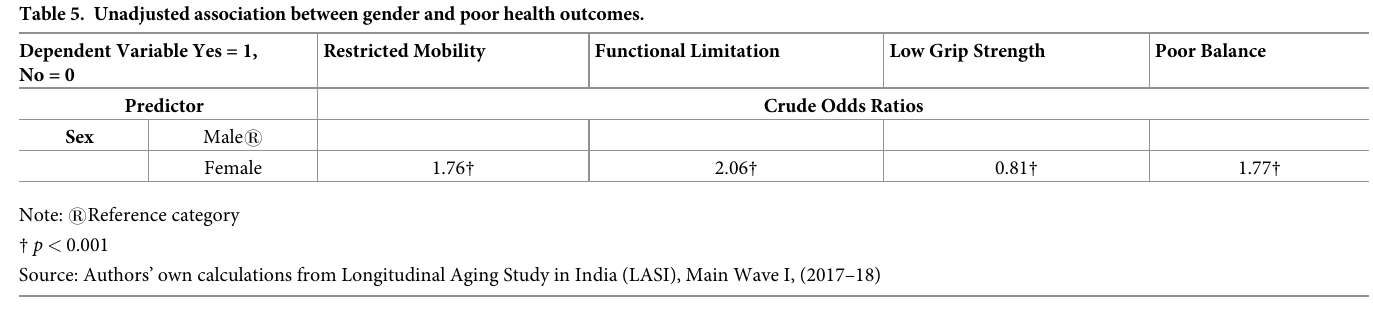
Table 6 presents the adjusted effect of gender on each of the subjective and objective health measures computed through the logistic regression models, controlling for successive vectors of demographic and social support variables; socioeconomic factors and pre-existing health conditions; and empowerment indicators in three different models (models 1–3). When addi- tional controls for demographic and social support (model 1); and socioeconomic factors and health conditions (model 2) were accounted for, the magnitude of the gender differences in health outcomes contracted but persisted and remained significant nonetheless, disfavouring older women in all but prevalence of low grip strength. With the controlling of the effect of indicators of financial empowerment (model 3), the magnitude of gender difference further shrunk but remained statistically significant only for restricted mobility and low grip strength. upon controlling for the effect of financial empowerment.